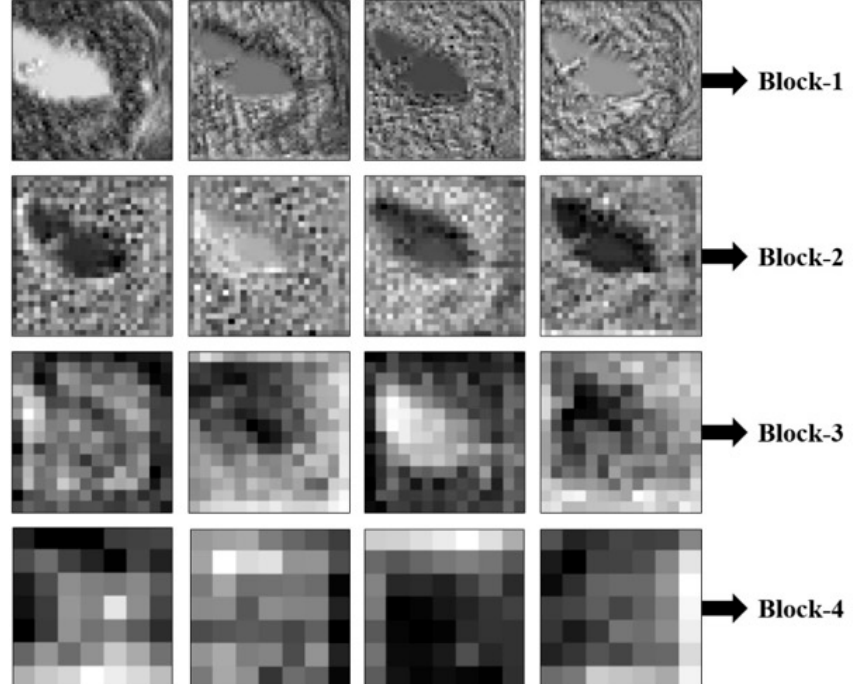
Figure 7. Multilevel feature map analysis for tissue image classification using a lightweight convolutional neural network. Visual analysis was performed by observing the pixel pattern in feature maps extracted from each block. Each block holds different information that is useful for convolutional neural network classification. Output shapes of feature maps from blocks 1 − 4 were: 56 × 56 × 92, 28 × 28 × 192, 14 × 14 × 384, and 7 × 7 × 512, respectively. Shown are four feature maps per block for the purpose of analysis, with 92, 192, 384, and 512 in each block, respectively. Analysis reveals that block-4 contains the maximum information regarding the image, but the resulting maps are less visually interpretable by people. With advancement deeper into the network, the feature maps become sparser, indicating that convolution filters detect fewer features. Therefore, block-4 was removed from model 2.